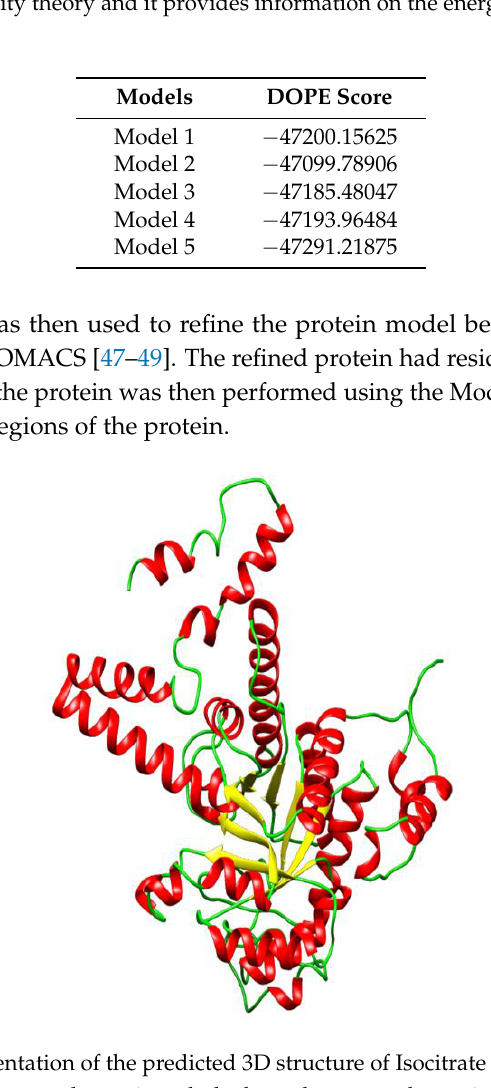
Figure 1. Cartoon representation of the predicted 3D structure of Isocitrate lyase of the Mycobacterium ulcerans . The alpha helices are shown in red, the beta sheets are shown in yellow, and the loops are shown in green.